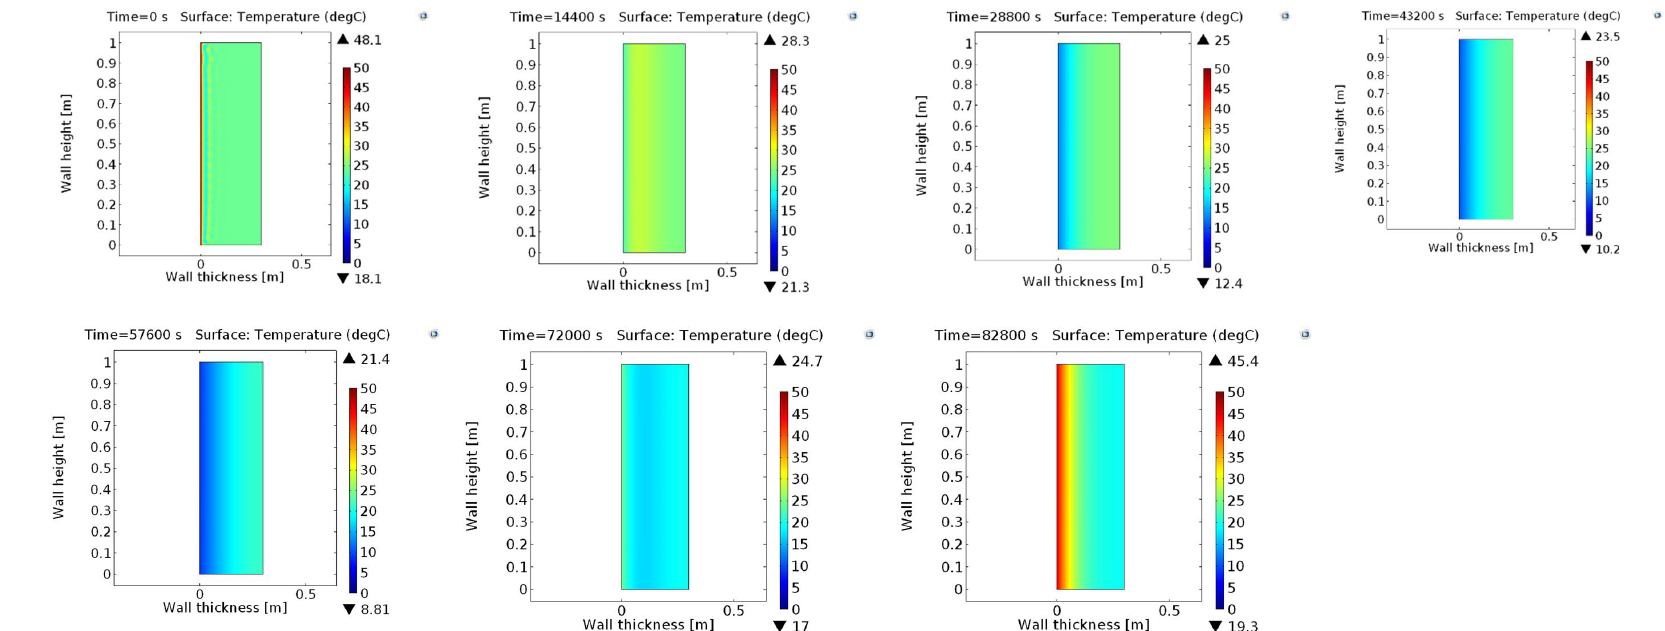
Figure 3. Two-dimensional (2D) temperature contours for a time period of 24 h (time step: 4 h) for the exposed wall of thermal conductivity of 1 W/m K in sunny spring conditions (SSE), using 24-h actual surface temperature data for the modeling of the external boundary conditions. Note: left-hand boundary of the model: exterior wall surface; right-hand boundary of model: interior wall surface.